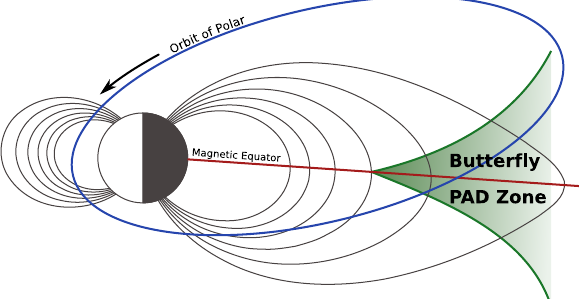
Fig. 2. When Polar passed through the nightside equatorial plane, it was on an outbound trajectory going from the Southern to the Northern Hemisphere into a region where the butterfly PAD is ob-